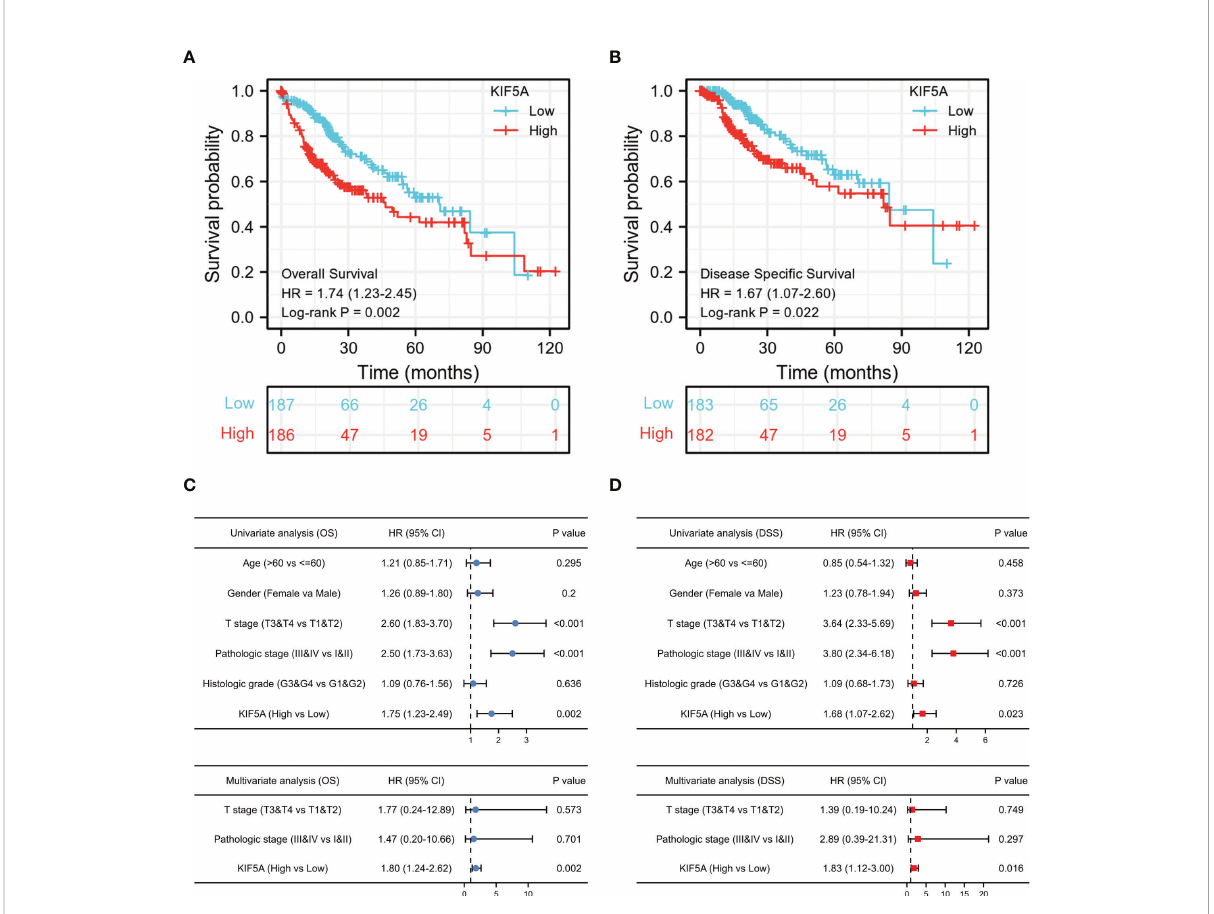
FIGURE 2 Increased KIF5A expression is Correlated with Unfavorable Prognosis. (A) Patients with upregulated KIF5A expression tended to have relatively lower OS (p= 0.002). (B) Patients with upregulated KIF5A expression tended to have relatively lower DSS (p= 0.022). (C) Univariate and multivariate Cox regression analysis of OS. (D) Univariate and multivariate Cox regression analysis of